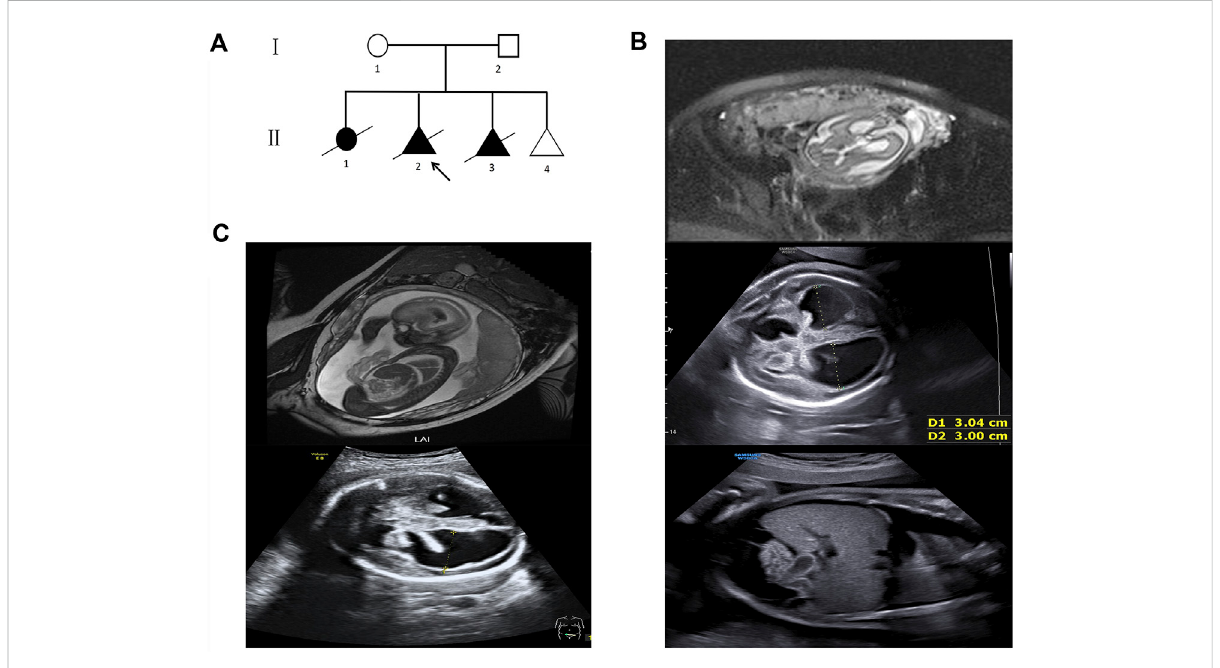
FIGURE 1 Pedigree and fetal ultrasound scan and MRI fi ndings. (A) Pedigree of the family. The arrow refers to the proband. The solid circle (female) and triangle (fetus) represent the affected siblings; (B) ultrasound and MR imaging in the fetus (II 2): the enlarged bilateral ventricles, intraventricular hemorrhage and severe hydrocephalus, the infantile edema of the skin, bilateral pleural effusion, and ascites in the fetus; (C) ultrasound and MR imaging in the fetus (II 3): the enlarged bilateral ventricles, intraventricular hemorrhage, and severe hydrocephalus in the